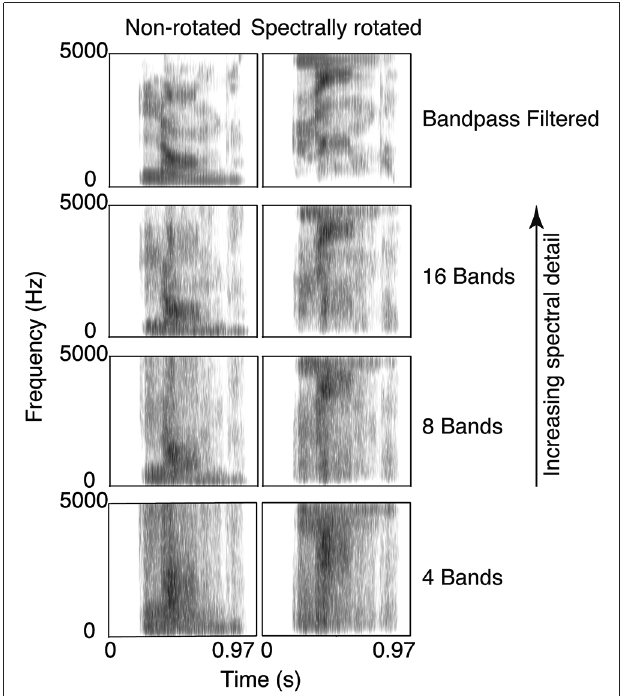
FIGURE 1 | Spectrograms of the French word “langue” (meaning tongue, or language) for the four levels of spectral detail, for spectrally rotated and non-rotated stimuli . Stimuli illustrated with a preceding 200 ms silence.